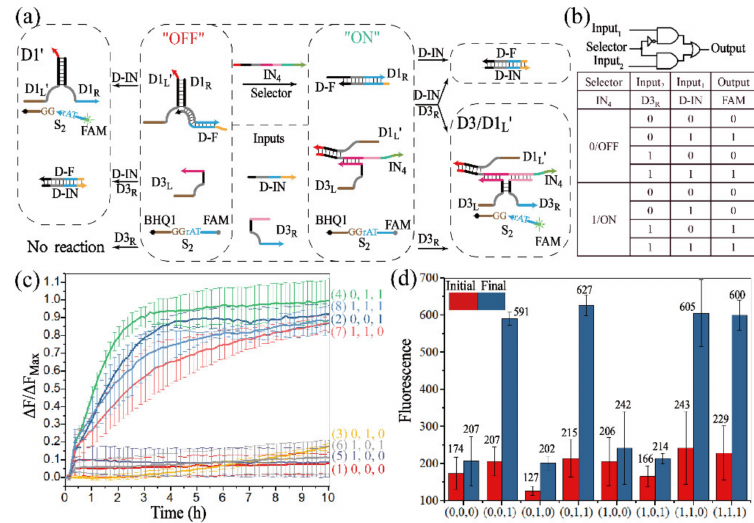
Figure 5. ( a ) Schematic diagram of the 2:1 MUX. ( b ) Truth table and logical operations of the 2:1 MUX. ( c ) Time-dependent normalized fluorescence curves. The fluorescence intensities are recorded every 10 min. “OFF” state: the selector IN 4 is absent, (1) no input is added; (2) D-IN is added; (3) D3 R is added; (4) D-IN and D3 R are both added. “ON” state: the selector IN 4 exists, (5) no input is added; (6) D-IN is added; (7) D3 R is added; (8) D-IN and D3 R are both added. ( d ) The real fluorescence changes of 2:1 MUX. The initial state: red columns, and the final state: blue columns.